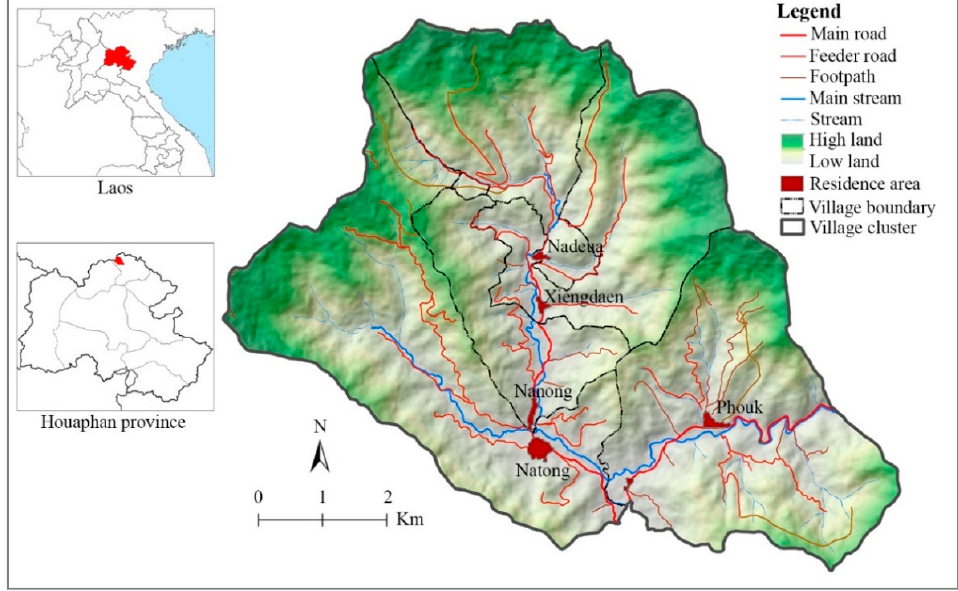
Figure 1. Location of the study site.